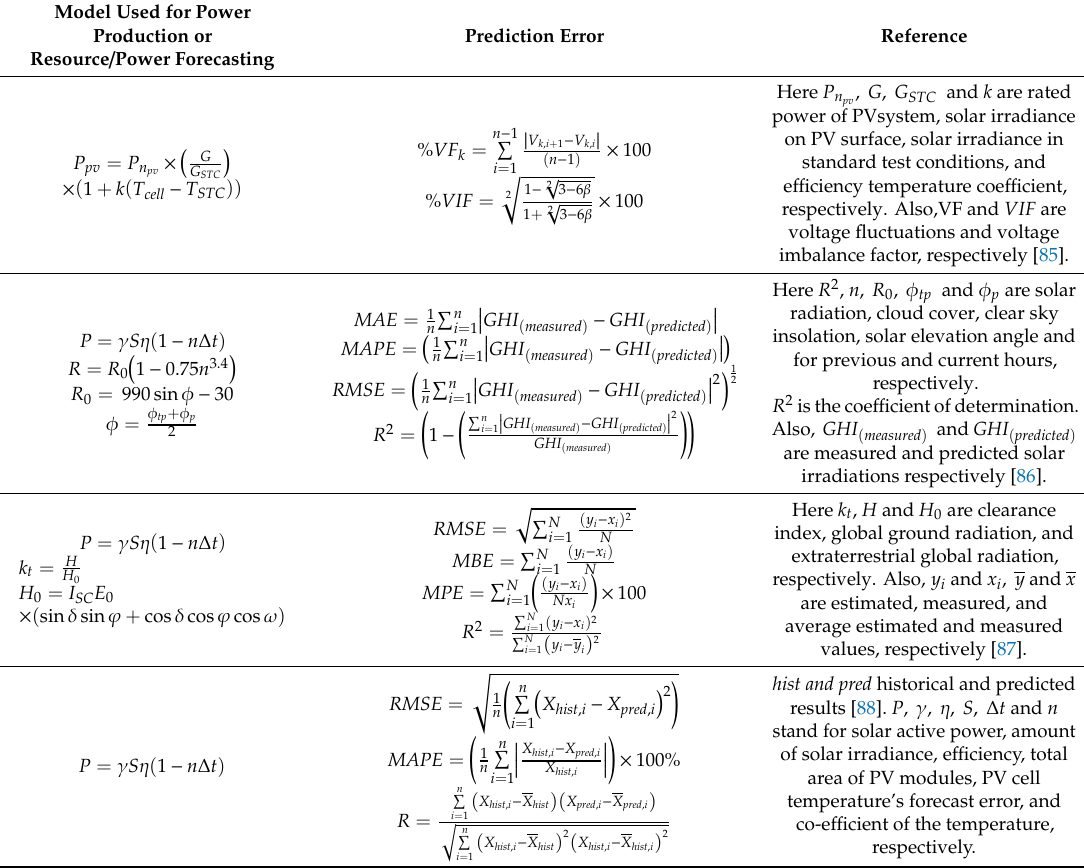
Table 5. Photovoltaic (PV) power forecasting with the incorporation of